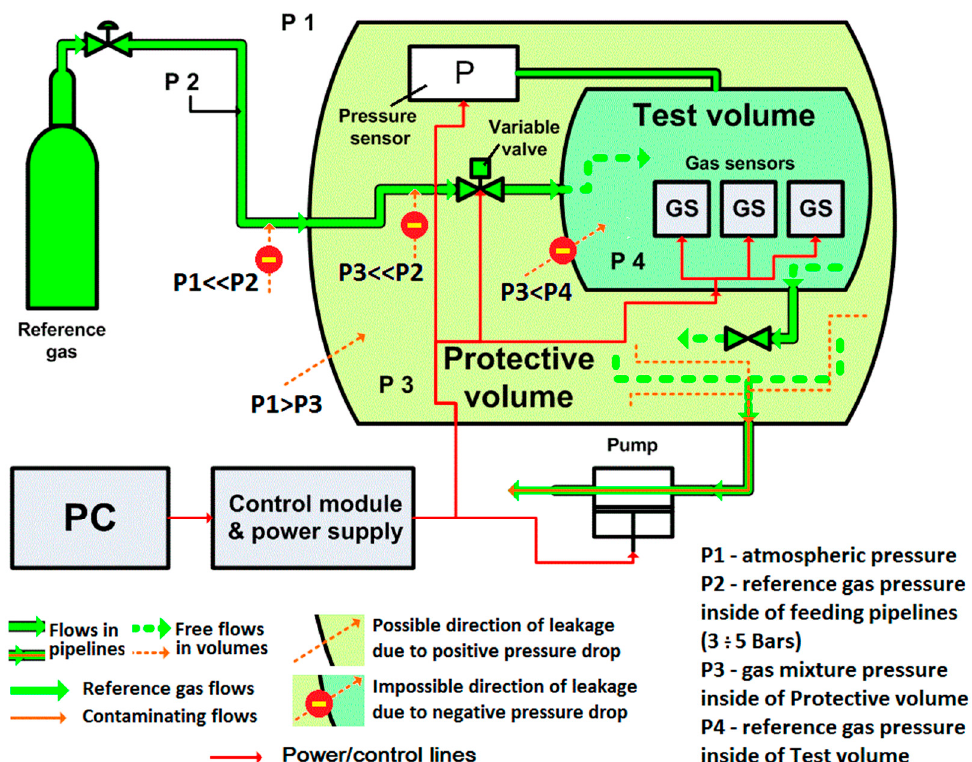
Figure 6. Schematic of the pressure calibration system. Protection against possible contamination from ambient concentration is based on a pressure drop. The pressure drop is developed by maintaining the pressure in the test volume higher than in the protection volume.